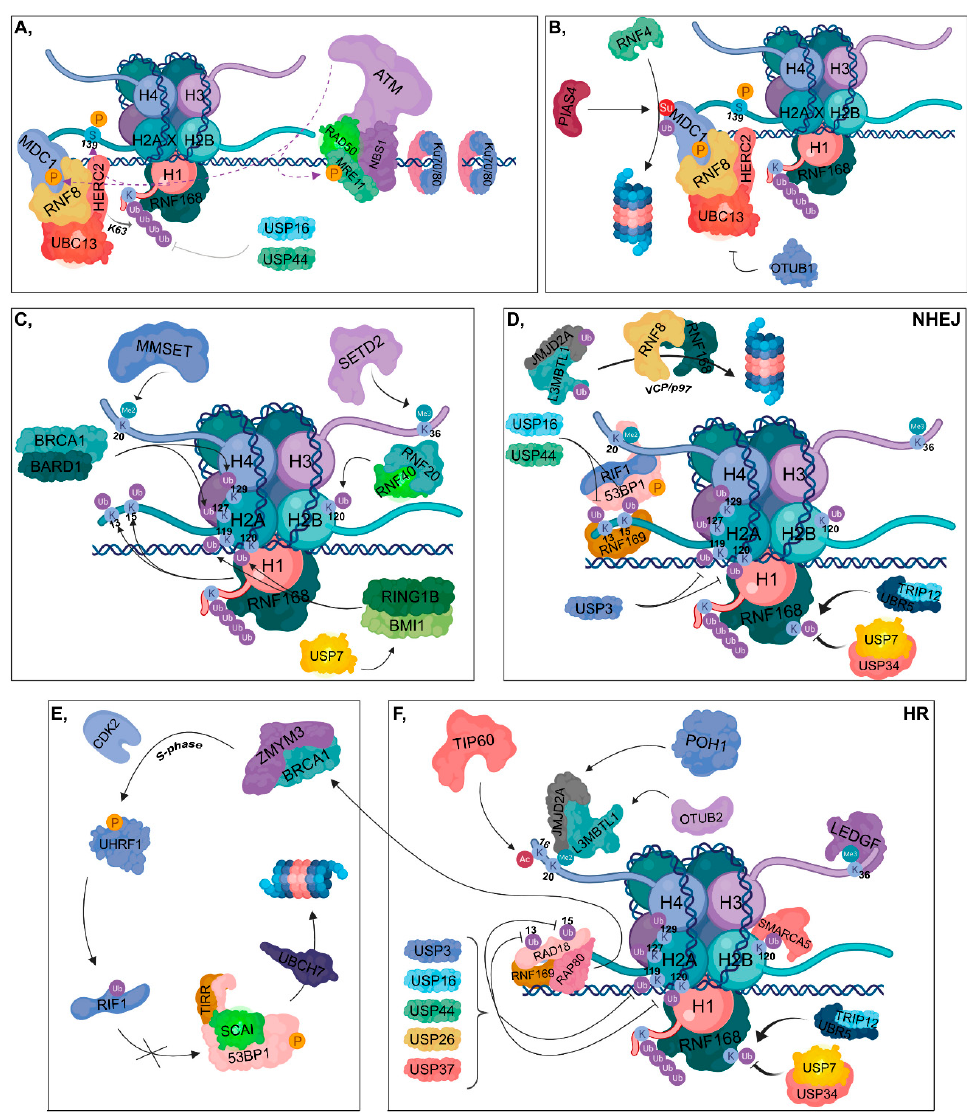
Figure 2. DNA damage response (DDR). ( A ) Ku70 / 80 heterodimers bind to broken DNA ends. The RAD50-NBS1-MRE11 complex is recruited resulting in the binding of ATM, which in turn phosphorylates MRE11, MDC1 and H2AX at Ser139. The RNF8-HERC2-UBC13 complex binds to phosphorylated MDC1. RNF8 is responsible for the K63-linked polyubiquitylation of H1, which can be reversed by the contribution of USP16 and USP44. RNF168 is recruited to polyubiquitylated H1. ( B ) PIAS4 SUMOylates MDC1, which is then ubiquitylated by RNF4, resulting in its proteasomal degradation. OTUB1 can inhibit UBC13, therefore hindering the DDR. ( C ) RNF168 catalyzes the ubiquitylation of H2A at its K13 and K15 residues, while BRCA1-BARD1 ubiquitylates H2A at K127 and K129. The RNF20-RNF40 is responsible for K120 ubiquitylation of H2B. RING1B-BMI1, stabilized by USP7, ubiquitylates H2A at K119 and K120. MMSET catalyzes H4K20 dimethylation and SETD2 trimethylates the H3K36 residue. ( D ) During NHEJ, RNF169 can bind to the ubiquitylated K13 and K15 lysine amino acids of H2A competing with the 53BP1-RIF1 complex to the same sites. However, these ubiquitins can be removed by USP16 and USP44. 53BP1-RIF1 can bind to H4K20me 2 site as well. USP3 deubiquitylates H2A at K119 and K120. TRIP12 and UBR5